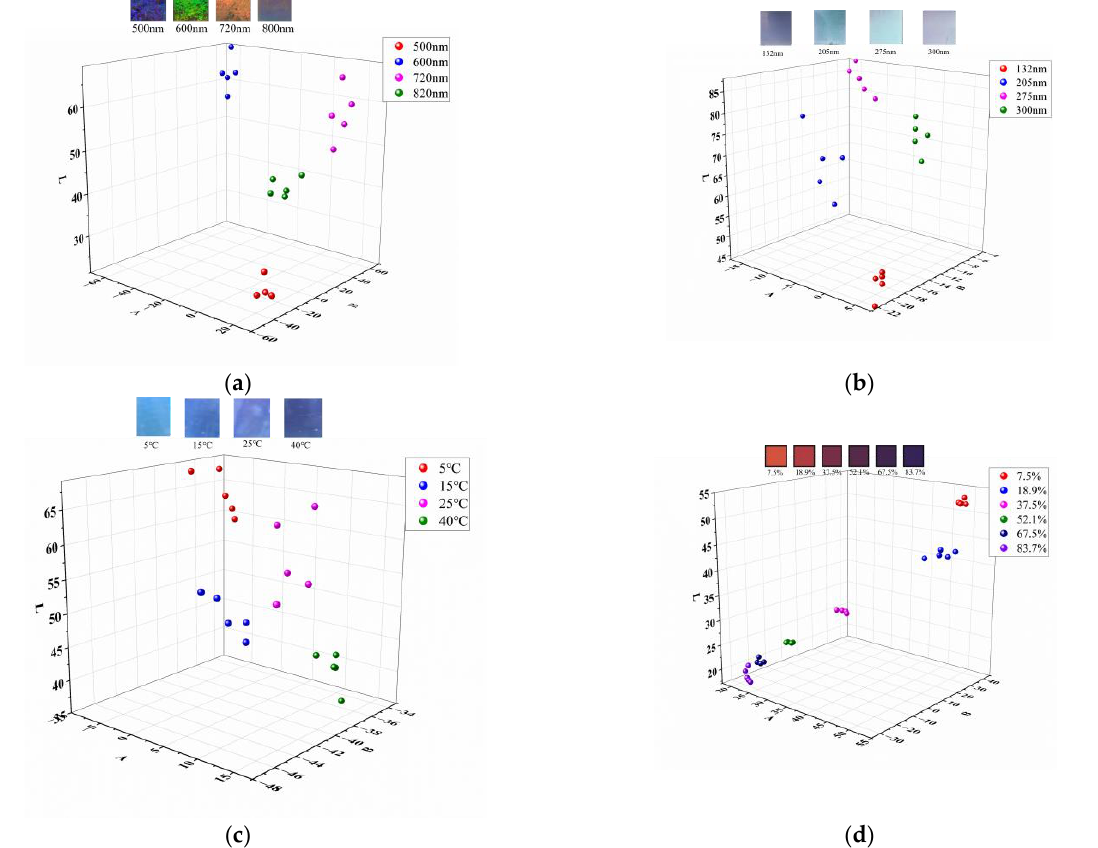
Figure 2. ( a ) Distribution of 2D photonic crystal color palettes in CIELAB color space; ( b ) distribu- tion of 3D photonic crystal color palettes in CIELAB color space; ( c ) distribution of color palettes in CIELAB color space of photonic crystal hydrogel films at different temperatures; ( d ) distribution of color palettes in CIELAB color space of photonic crystal hydrogel films at different humidity.